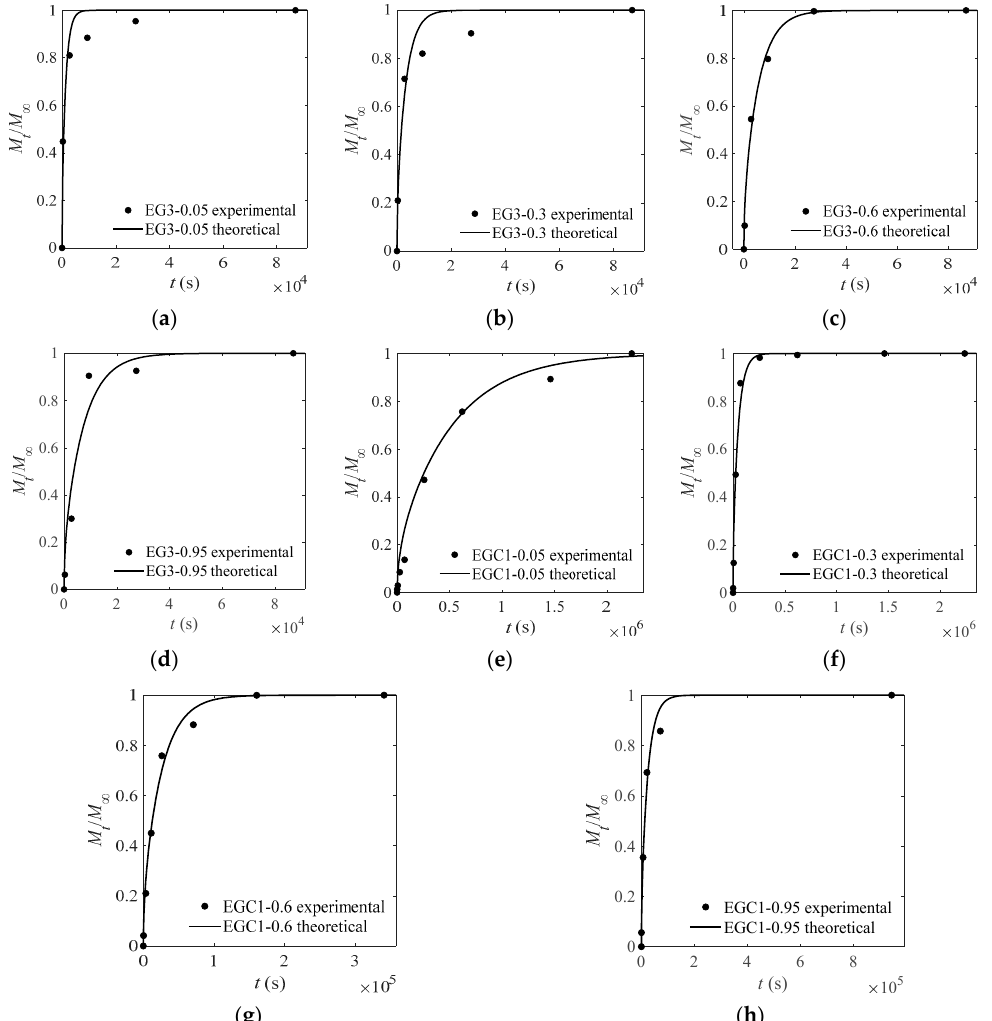
Figure 5. Experimental and theoretical values of one-way release tests of CEOs released from films EG ( a ), EGA ( b ), EGC ( c ) to water at 4 °C.